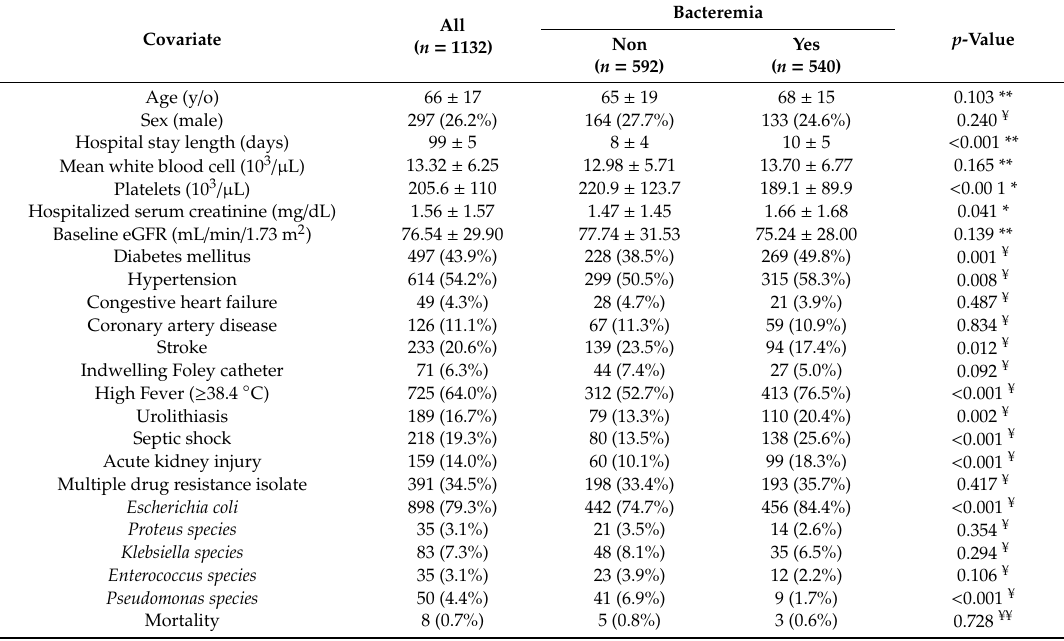
Table 4. Characteristics of hospitalized patients with urinary tract infection with respect to bacteremia. All Covariate ( n = 1132)